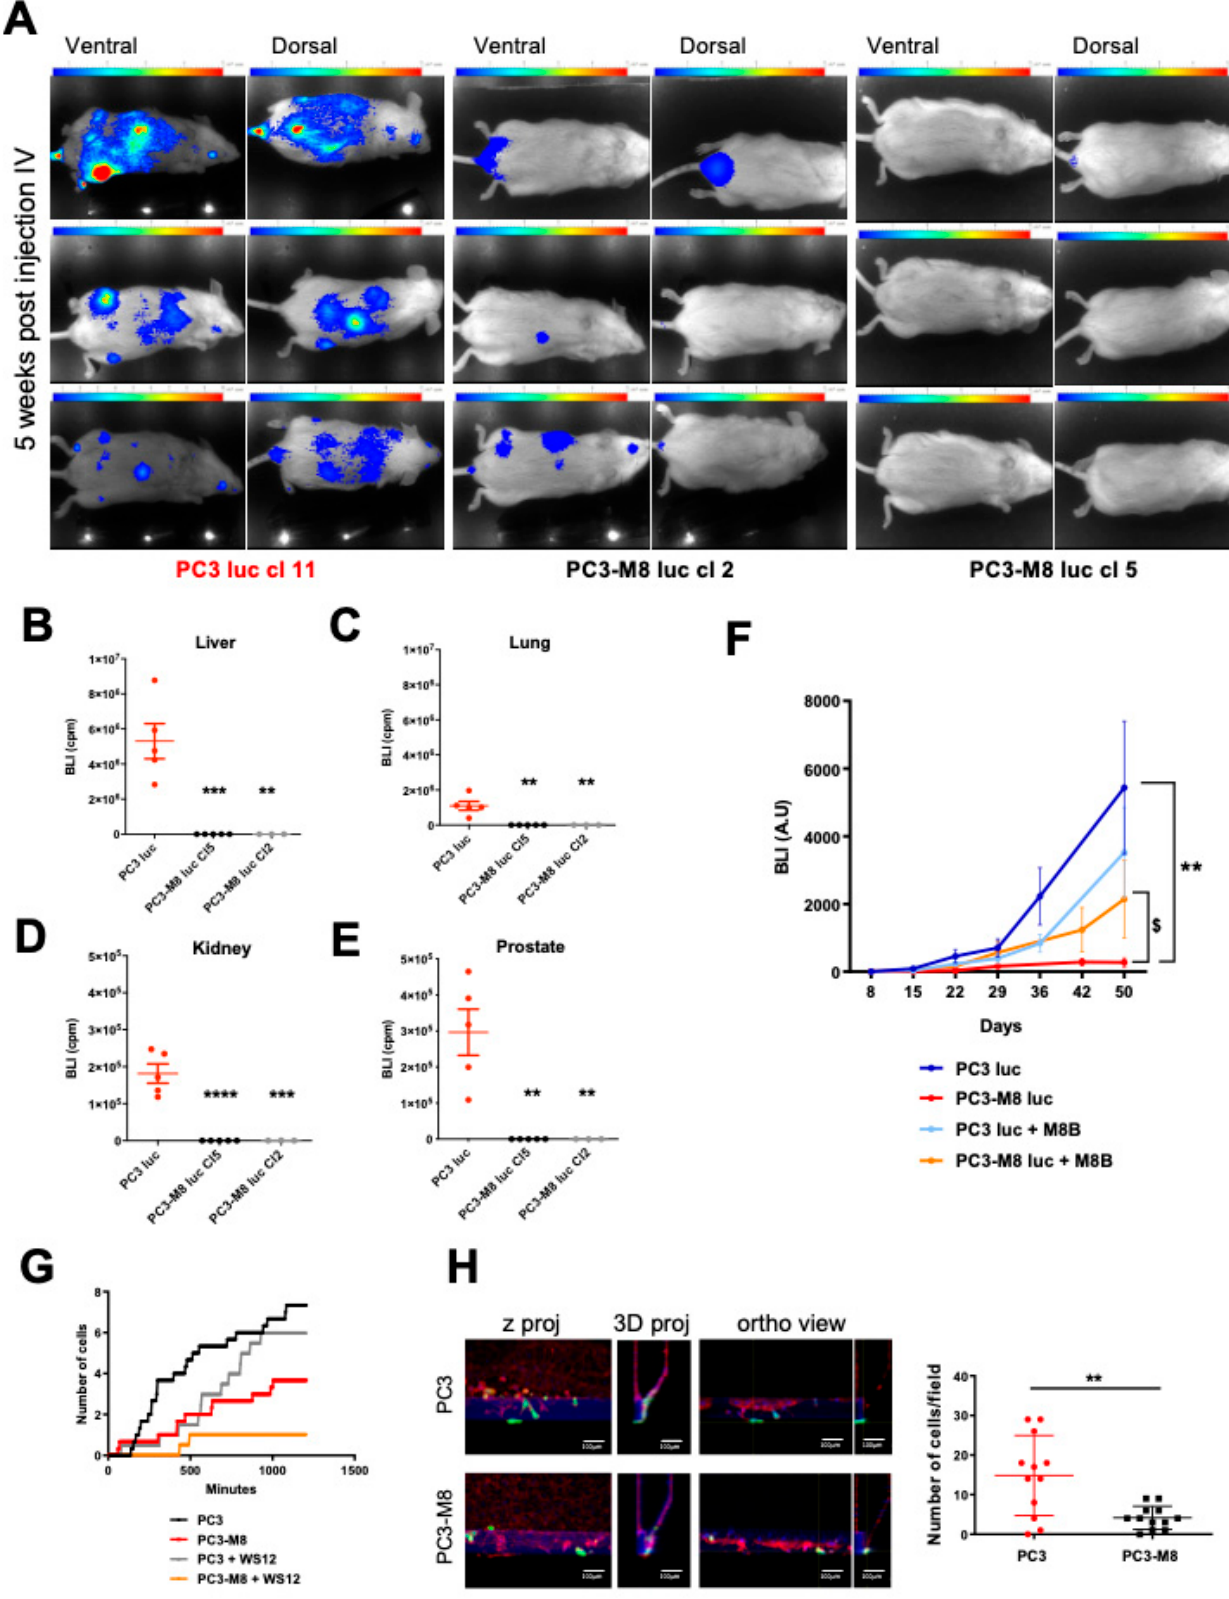
Figure 5. TRPM8 overexpression in PC3 inhibits metastatic dissemination. PC3 luc or PC3–M8 luc cells were engrafted into NSG mice by tail vein injection, and tumor burden was noninvasively monitored by measuring the bioluminescence signal generated upon subcutaneous administration